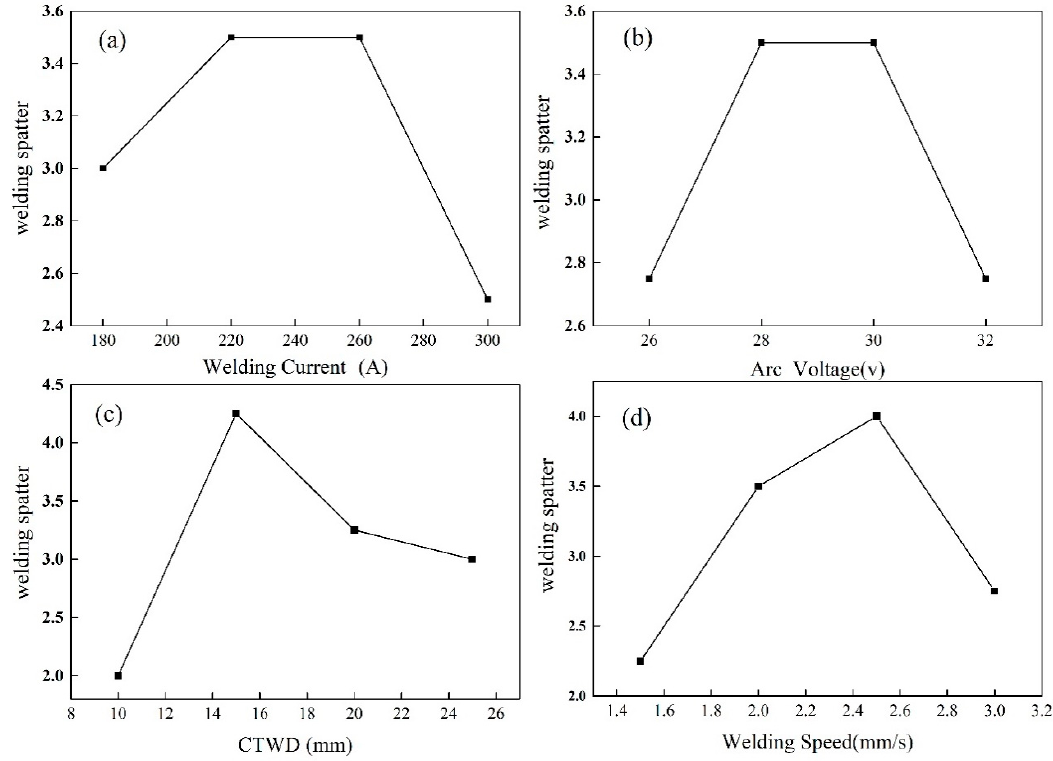
Figure 4. Influence of welding parameters on welding spatter. ( a ) welding current; ( b ) arc voltage; ( c ) CTWD; ( d ) welding speed.